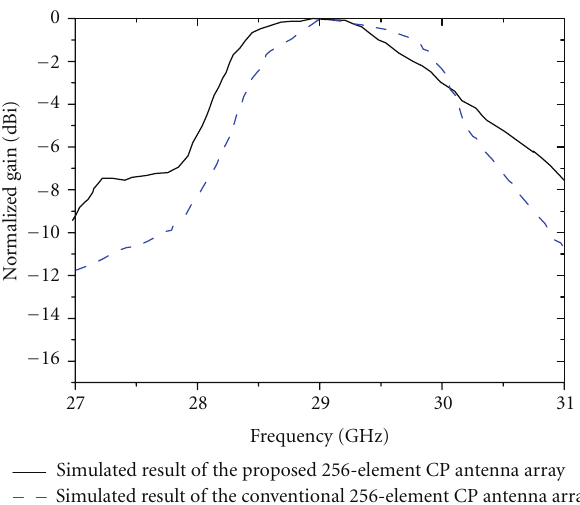
Figure 17: Simulated gain of the 256-element CP antenna arrays.